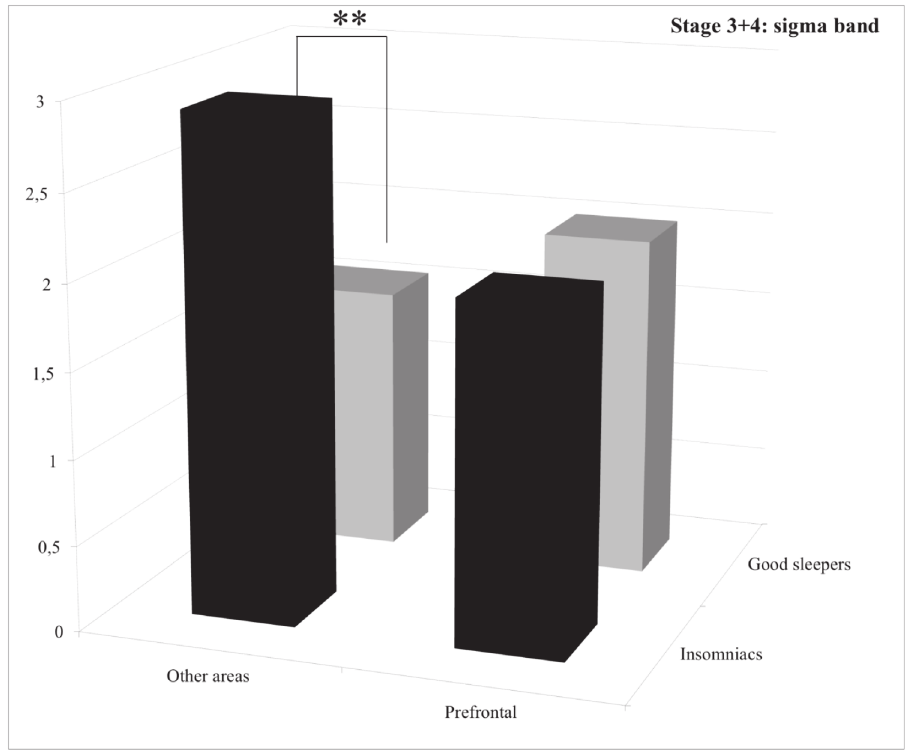
Figure 4. Relative power spectra for the sigma band during stage 3+4 for both groups (insomnia patients and good sleepers) and each areas (others vs prefrontal). ** p < 0.05.